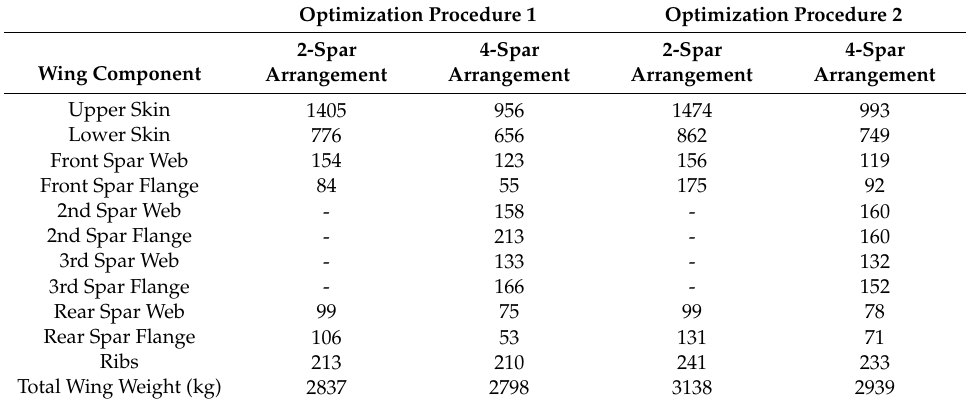
Table 1. Detailed final mass breakdown of the 2-spar and the 4-spar composite wing structural